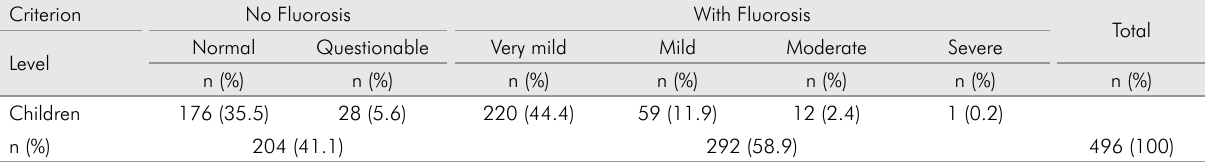
Table 1. Distribution of the numerical and percentage values of the 496 twelve-year-old children examined, according to fluorosis level. Birigui, SP, Brazil, 2014.